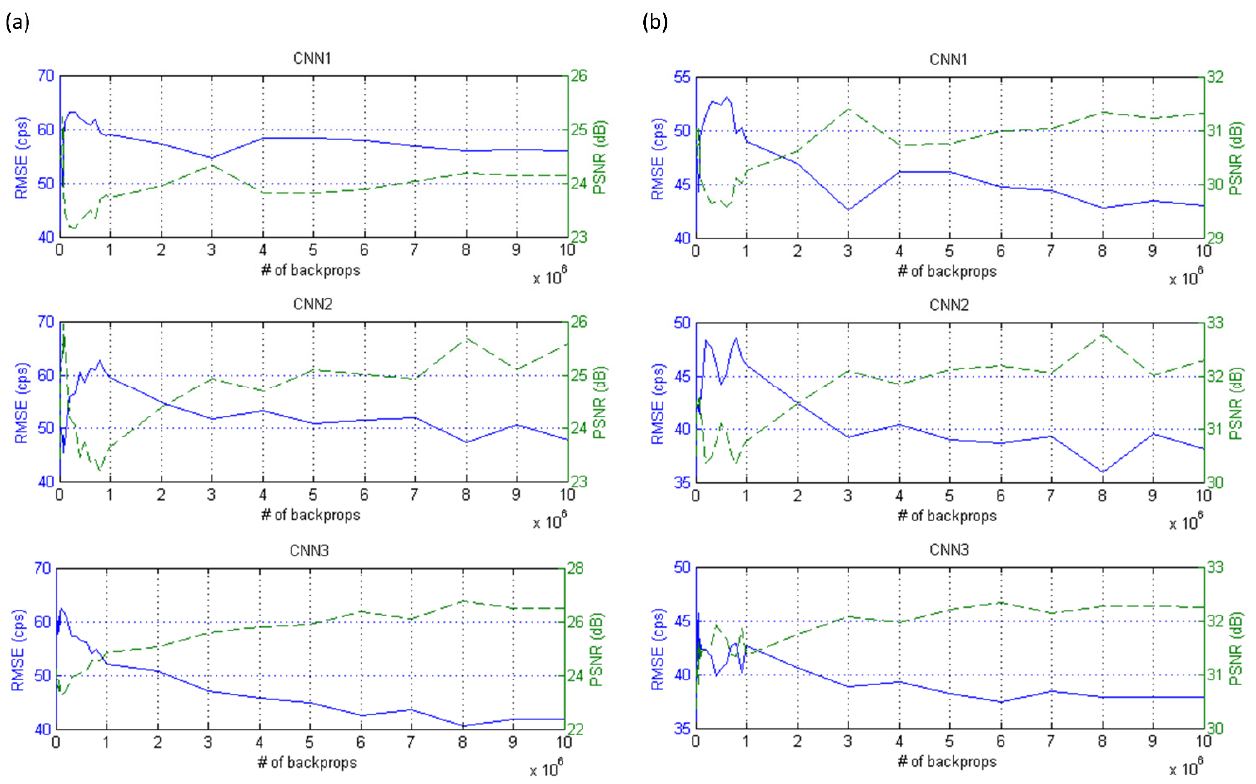
Figure 5. RMSE (solid line, left axis) and PSNR (dashed line, right axis) between I gamma and I PRC for ( a ) PHAN brain and ( b ) PHAN 5rod with TBR = 10 (top row: CNN1-based correction; mid row: CNN2-based correction; bottom row: CNN3-based correction).